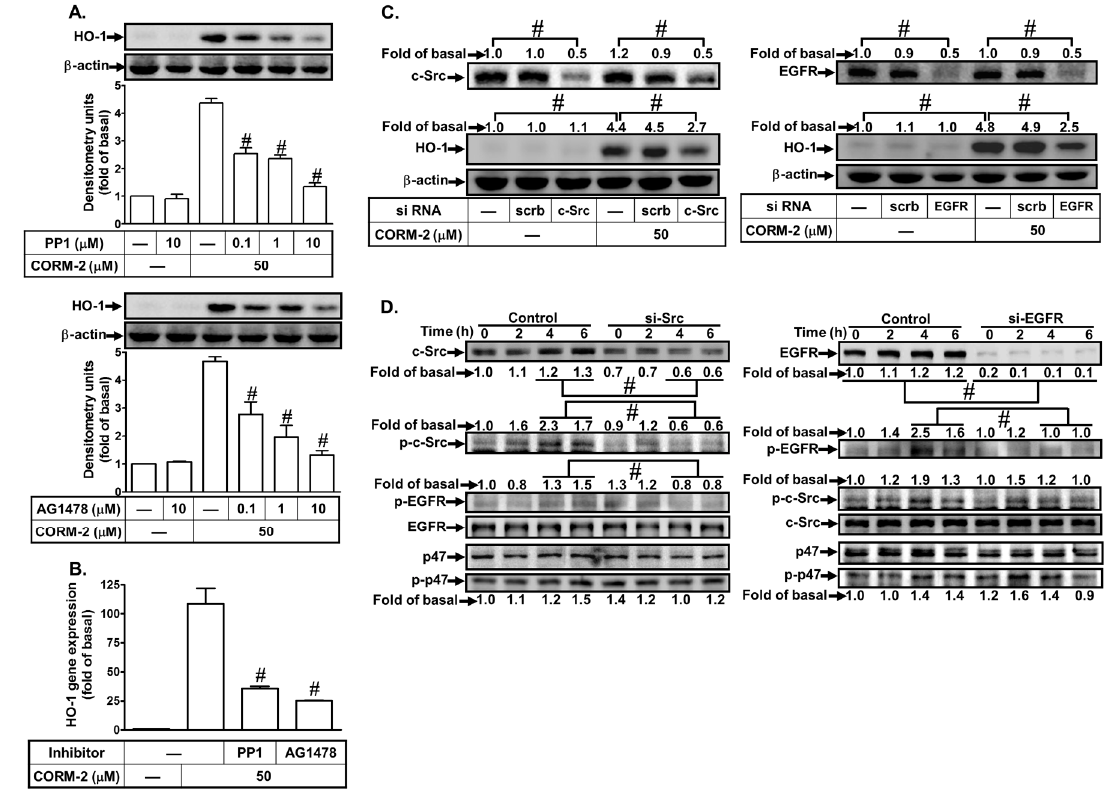
Figure 5. CORM-2 induces c-Src/EGFR-dependent HO-1 expression. ( A ) HPAEpiCs were pretreated with PP1 or AG1478 for 1 h and then incubated with CORM-2 for 16 h. The protein levels of HO-1 and β -actin were determined by western blot. ( B ) Cells were pretreated with PP1 (10 µ M) or AG1478 (10 µ M) for 1 h and then incubated with CORM-2 for 6 h. The mRNA expression of HO-1 was determined by real-time PCR. ( C ) Cells were transfected with scrambled, c-Src, or EGFR siRNA and then incubated with CORM-2 for 16 h. The levels of c-Src, EGFR, HO-1, and β -actin protein were determined by western blot. ( D ) Cells were transfected with scrambled, c-Src, or EGFR siRNA and then incubated with CORM-2 for the indicated time intervals. The levels of c-Src, EGFR, p47, phospho-c-Src, phospho-EGFR, phospho-p47, and β -actin protein were determined by western blot. Data are expressed as mean ± S.E.M. of three independent experiments ( n = 3). # p < 0.01, as compared with the cells exposed to CORM-2 alone or compared between the indicated groups.